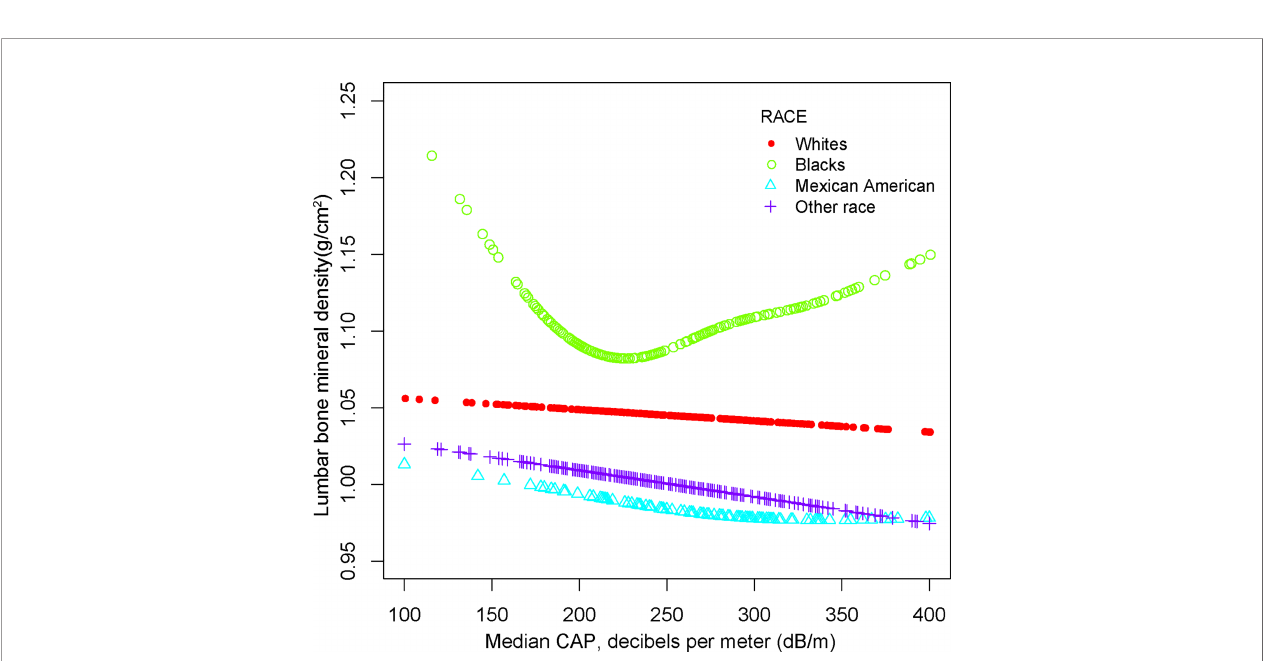
FIGURE 4 | The association between NAFLD and lumbar bone mineral density strati fi ed by race. Age, gender, race, body mass index, poverty to income ratio, education, diabetes status, waist circumference, Glycated hemoglobin, Total cholesterol, Triglyceride, LDL- cholesterol, HDL- cholesterol, ALT, ALP, GGT, AST, Serum creatinine, Serum iron, Lumbar bone mineral density, CAP and LSM were adjusted.